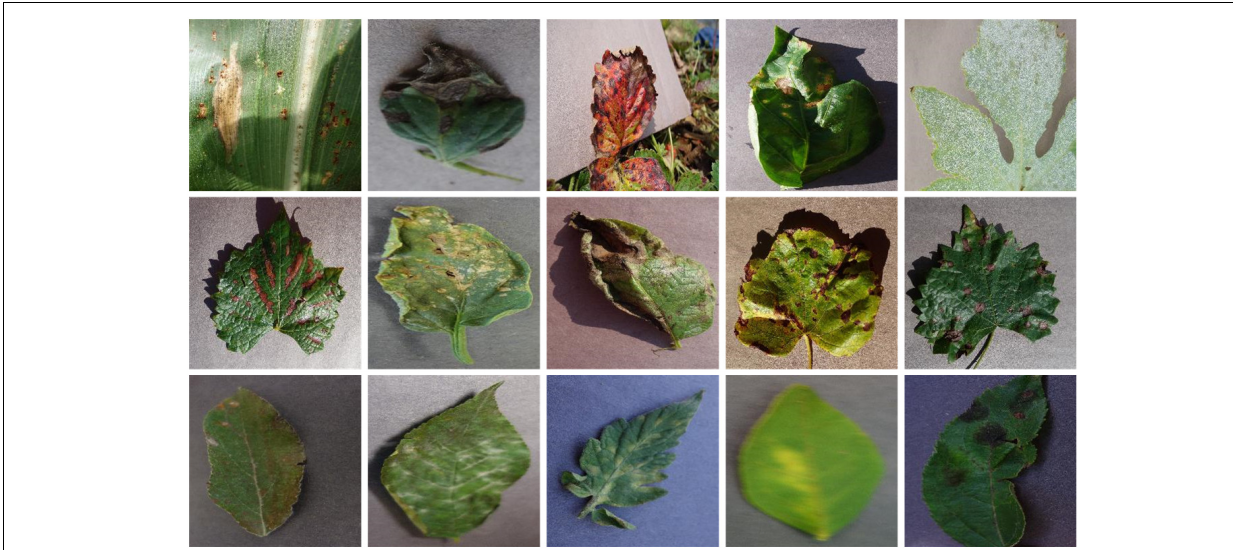
FIGURE 2 | Sample images of PlantVillage dataset.